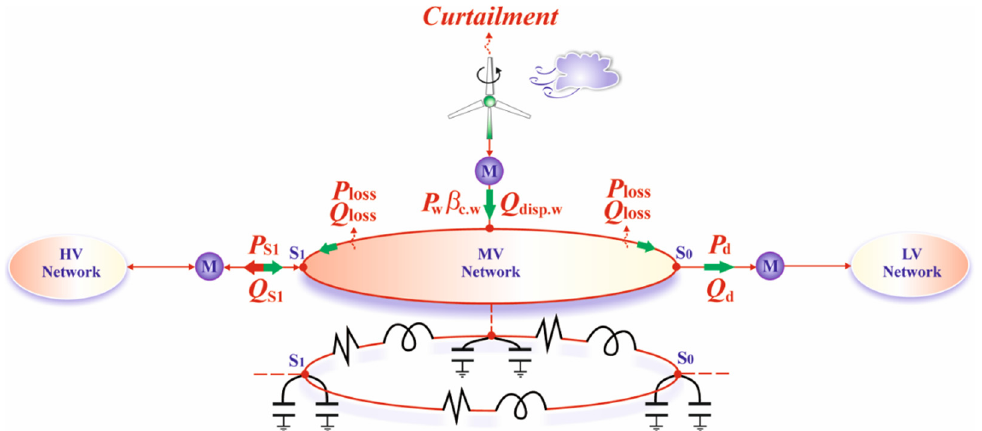
Figure 2. Illustration of the power system under consideration with a meter method [2]. In this paper, the low ‐ voltage (LV) network is considered with unidirectional power flows while the high ‐ voltage (HV) network with bidirectional power flows.